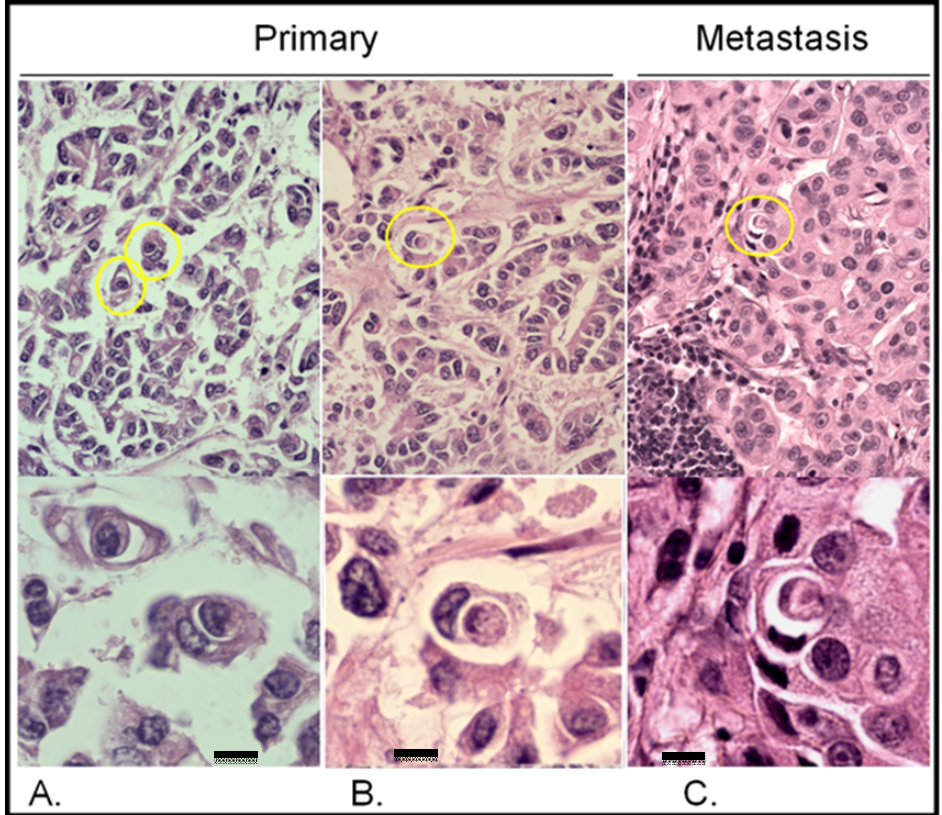
Figure 3. Entotic figures in the primary lesion and lymph node metastasis. The slides were stained with hematoxylin and eosin. ( A , B ) Entotic figures in the primary lesion. Top panels present entoses observed under a 10× microscope objective (marked using yellow circles) and the same cell ‐ in ‐ cell structures are displayed in a higher resolution (bottom panels; 40× microscope objective). ( C ) Lymph node metastasis: upper panel—10× microscope objective; lower panel—40× microscope objective. Scalebar 10 μ M.